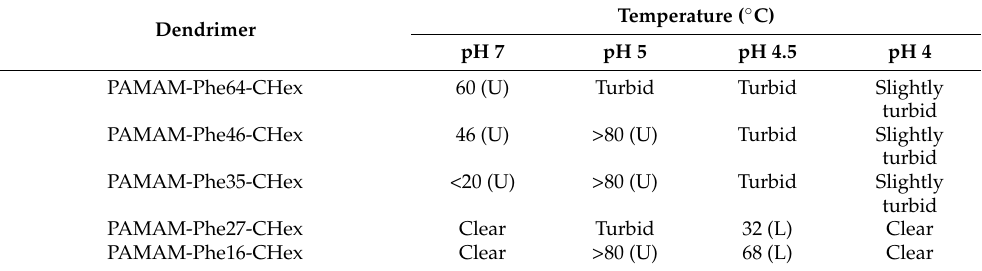
Table 2. pH-switchable thermosensitive behavior of PAMAM-Phe-CHex at different pH values 1 .